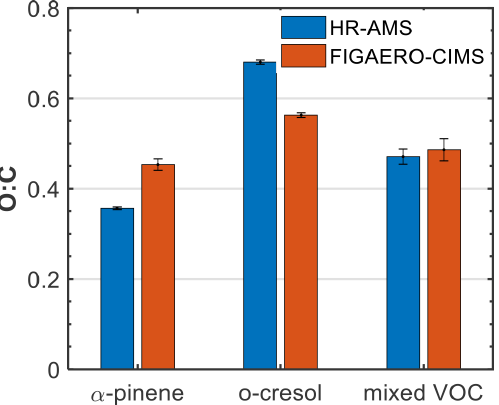
Figure 2. Average ( ± 1 σ ) oxygen-to-carbon (O : C) ratio for all the products identified in the particle phase from FIGAERO-CIMS and HR-AMS for each